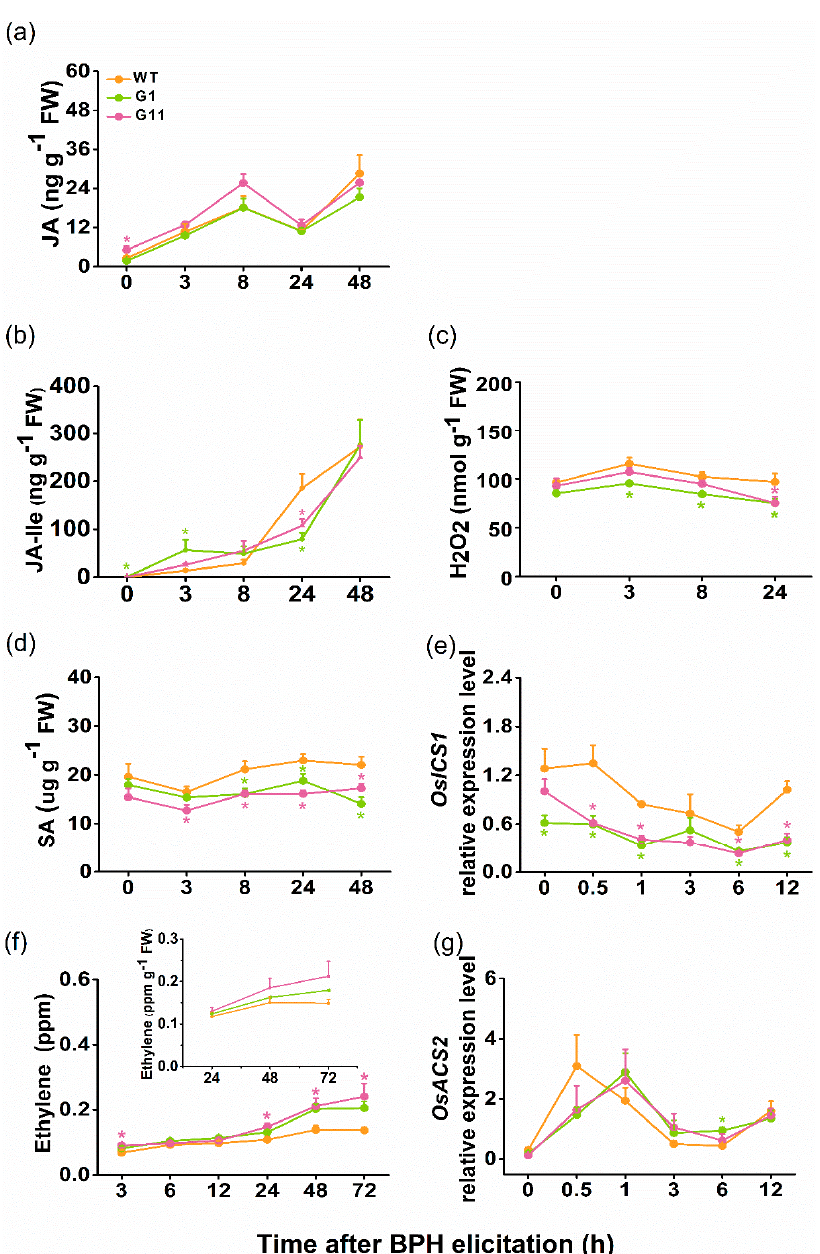
Figure 5. OsGID1 regulates the accumulation of BPH-induced JA, JA-Ile, H 2 O 2 , SA, and ethylene. ( a – d , f ) Levels (means + SE, n = 4–8) of JA ( a ), JA-Ile ( b ), H 2 O 2 ( c ), SA ( d ), and ethylene ( f , insert: ethylene levels per g biomass) in/from oe-GID1 and WT plants at different times after they were infested by 15 gravid BPH females; ( e , g ) Relative levels (means + SE, n = 5) of OsICS1 ( e ) and OsACS2 ( g ) in oe-GID1 and WT plants at different times after they were infested by 15 gravid BPH females. Asterisks indicate significant differences in oe-GID1 plants, compared with WT plants (Duncan’s multiple range test; * p < 0.05; ** p < 0.01).